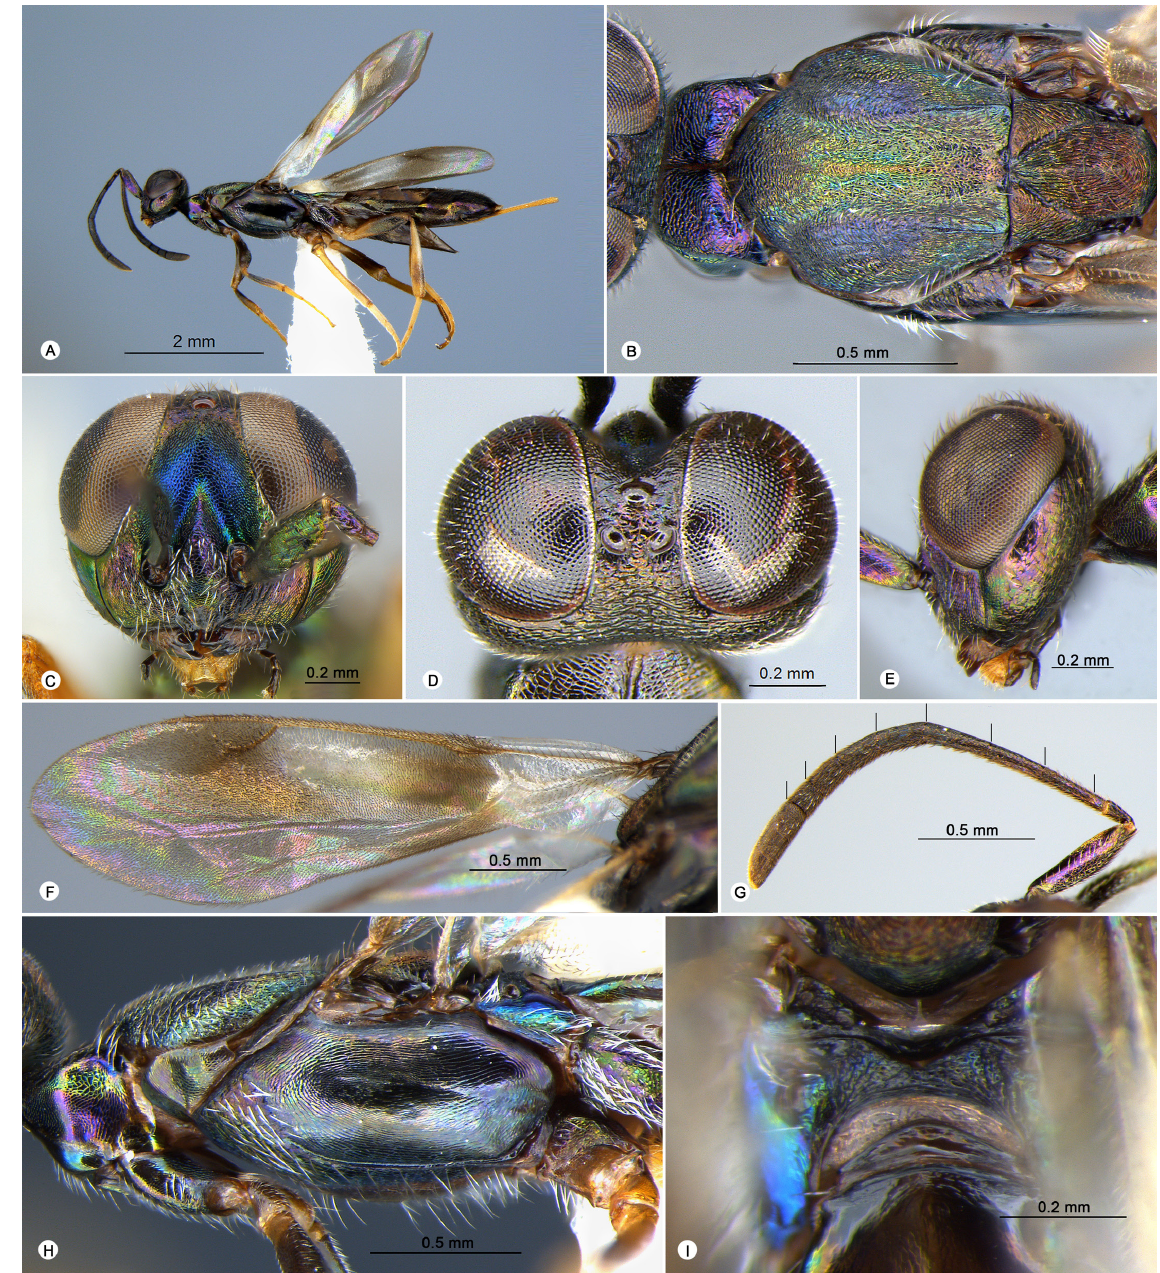
Fig. 3. Zaischnopsis lii Jiang & Peng sp. nov. A . Body, lateral view. B . Mesosoma, dorsal view. C . Head, front view. D . Head, dorsal view. E . Head, lateral view. F . Fore wing. G . Antenna. H . Mesosoma, lateral view. I .